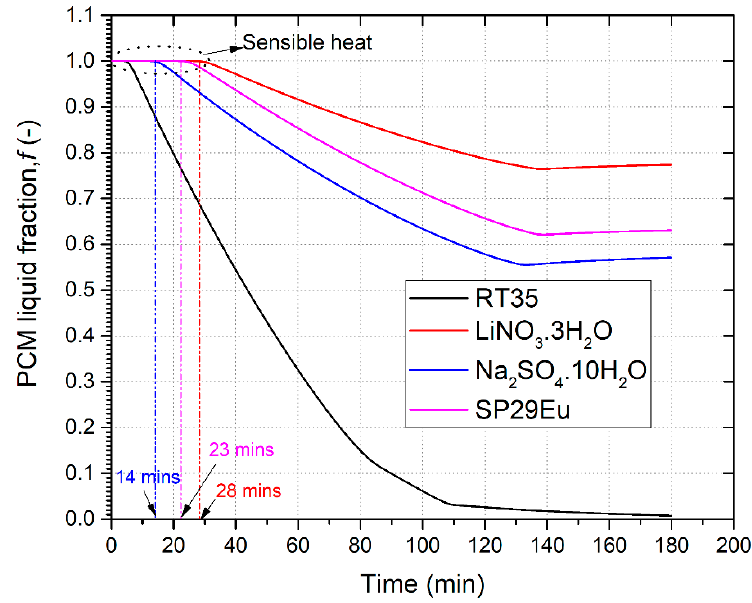
Figure 9. Temporal profile of PCMs liquid fraction.